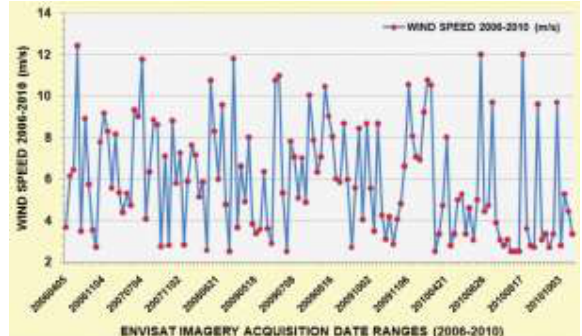
Figure 6. Wind speeds of acquired 136 multi-temporal ENVISAT images suitable for oil spill